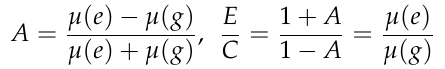
paper with tooltip text characterising the compound ID, solvent name, solvatochromic sensitivity, relation E/C, Absorption maxima, Emission maxima, Stokes shift, and Quantum yield.